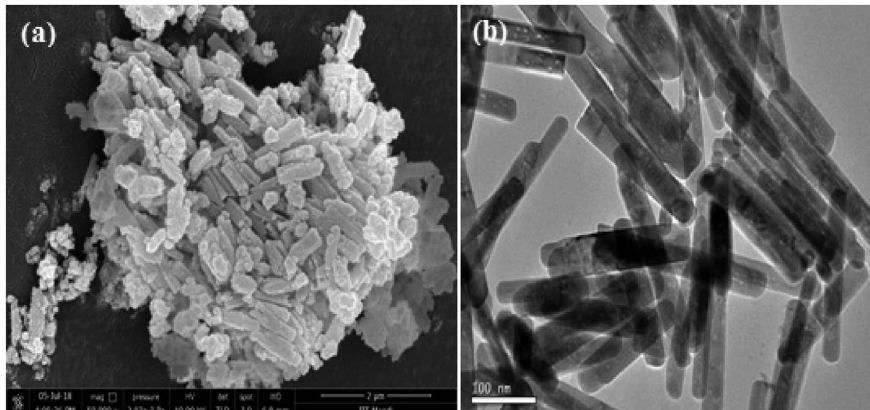
Figure 5. (a) SEM and (b) TEM images of YbPO 4 :Tb 3+ (HT)